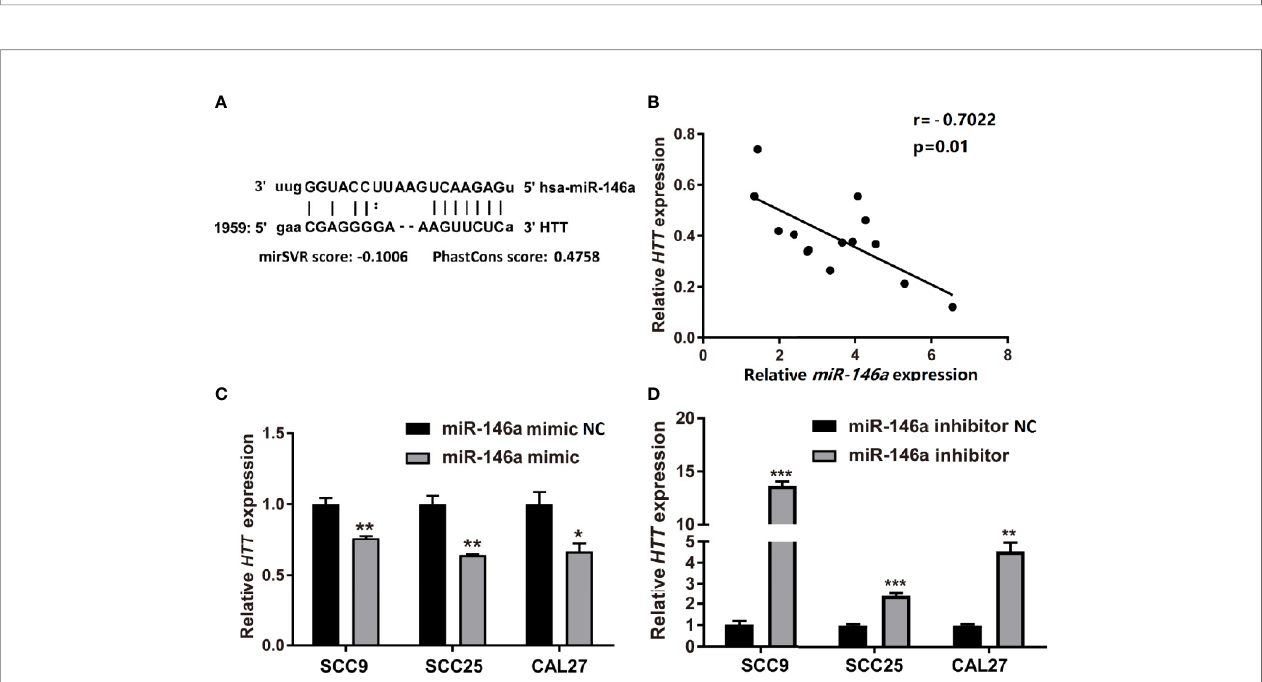
FIGURE 5 | HTT expression was inversely related to miR-146a expression in OSCC tissues. (A) The binding site of miR-146a in the HTT gene. (B) Pearson analysis showing the correlation between miR-146a and HTT mRNA expression level in OSCC tissues (n = 14; r = − 0.7022, P < 0.01). HTT expression pattern in (C) miR- 146a transfected, and (D) miR-146a knockdowned OSCC cells. Data are presented as mean ± SD form three independent experiments in triplicate. Signi fi cant effect of treatment, *P < 0.05, **P < 0.01, and ***P < 0.001. NC, negative control. Scale bar, 100 m m.